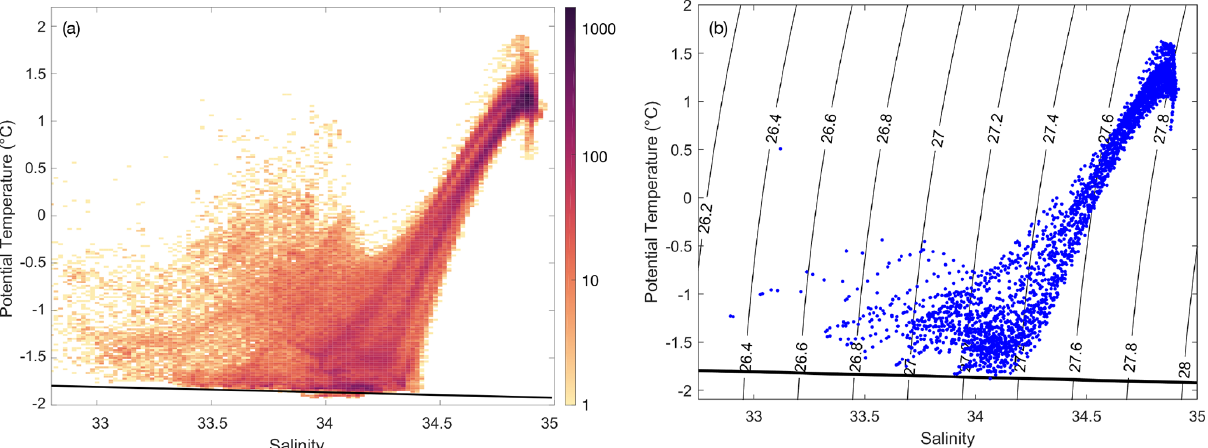
Figure 5. Potential temperature–salinity plots as measured by instrumented seals in the Bellingshausen Sea. (a) A two-dimensional histogram of all the seal data over the continental shelf, using salinity and temperature intervals of 0.02psu and 0.02 ◦ C, respectively. The scale is logarithmic. (b) The distribution of potential temperature and salinity from the composite hydrographic sections is listed in Table 1. The thin black contour lines are of potential density. The thick black line is the freezing